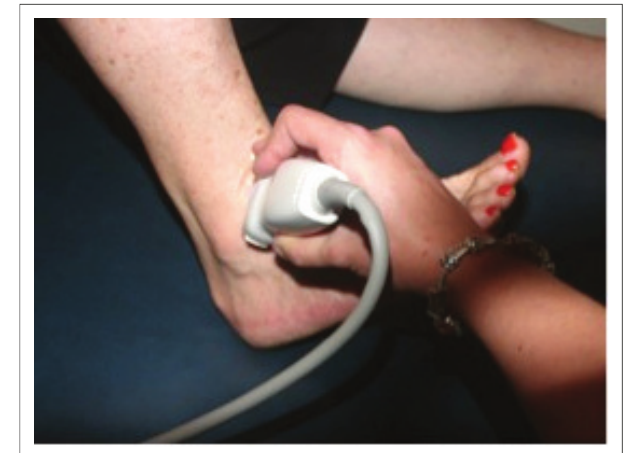
FIGURE 5: The distal aspect of the fibula is demonstrated as the bony element on the left and the tibia is demonstrated as the bony element on the right. Note the intact fibres of the anterior tibiofibular ligament as indicated by the thin white arrows.